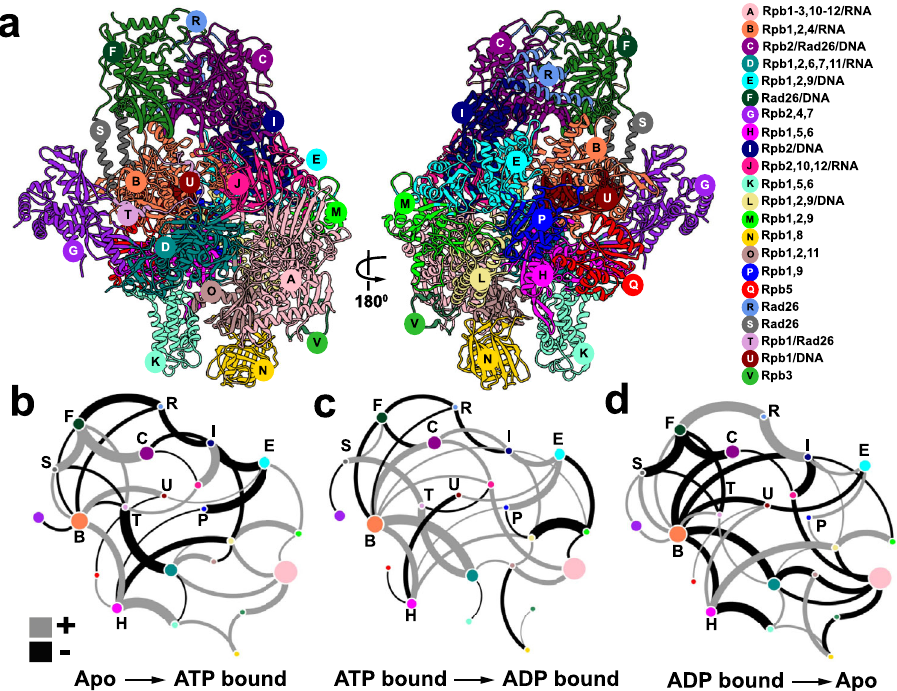
Fig. 4 Community networks underlying Pol II – Rad26 functional dynamics during the ATPase cycle. a Consensus communities are identi fi ed from dynamic network analysis and mapped to the structure of Pol II – Rad26 complex. Communities are color-coded and labeled. Net change in contact probabilities across Pol II – Rad26 communities during the ATP hydrolysis cycle: ( b ), apo to ATP transition; ( c ) ATP to ADP transition; ( d ) ADP to apo transition. The radius of community vertex is correlated to the number of residues included in the community. The gray and black edges between communities (betweenness) indicate gain( + )/loss( − ) of dynamic contacts.